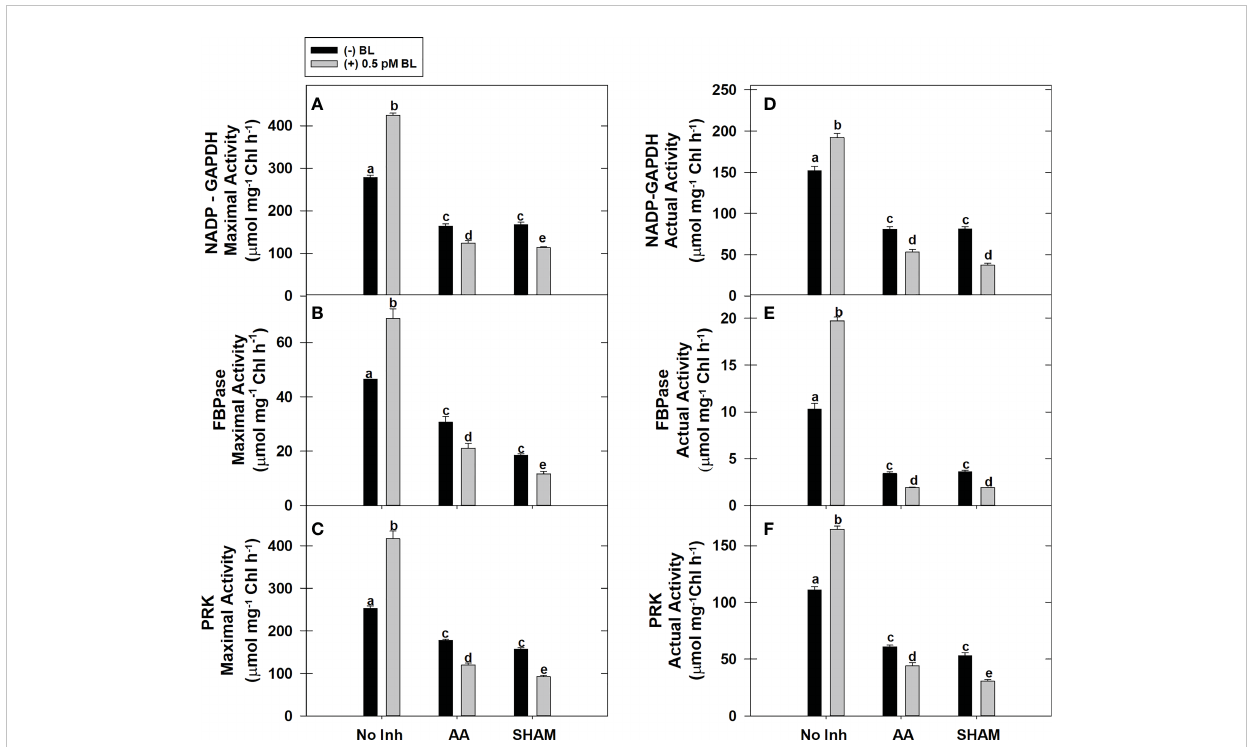
FIGURE 4 Effect of BL on maximal activity (A – C) and actual enzymatic activity (D – F) of NADP-GAPDH, Stromal FBPase, and PRK under the disruption of COX pathway or AOX pathway in MCP of A. thaliana . The MCP in the reaction medium was pre-incubated with or without 0.5 pM BL in the presence or absence of 100nM AA (COX pathway Inhibitor) or 0.5 mM SHAM (AOX pathway inhibitor) for 10 min at a light intensity of 1000 m mol m -2 s -1 at 25°C. After treatment, MCP was immediately used to monitor maximal and actual activity. Further, the section “ materials and methods ” mentions more detailed information on the procedure. No Inhibitor (No Inh) depicts a sample without mETC inhibitors. A statistically signi fi cant difference is represented by different lowercase alphabetical letters (P ≤ 0.05) and values represent the average (± SE) of three